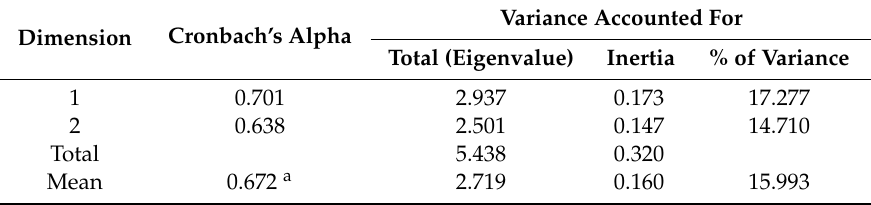
Table 5. Model summary for CATPCA.